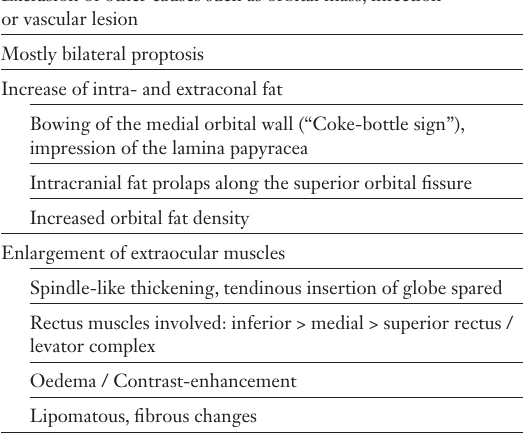
Suggestive MR- and CT- imaging findings for GO (modified according to